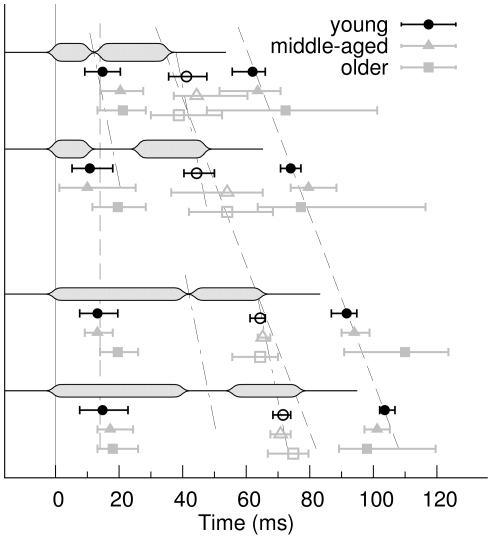
Group mean latencies of the high-gamma peak.Gap responses are marked with open symbols, onset and offset responses to the no-gap stimuli with filled symbols. The error bars denote the 95% confidence intervals for the group means. The dashed lines are parallels to the time points of sound onset and sound offset indicating that the latencies of the response to no-gap stimuli are well explained by a constant delay added to onset or offset latency. The dash-dotted lines are parallels to the mid points of the gaps and suggest that the latency of the gap responses (open symbols) are better explained by a constant delay with respect to the gap mid point.